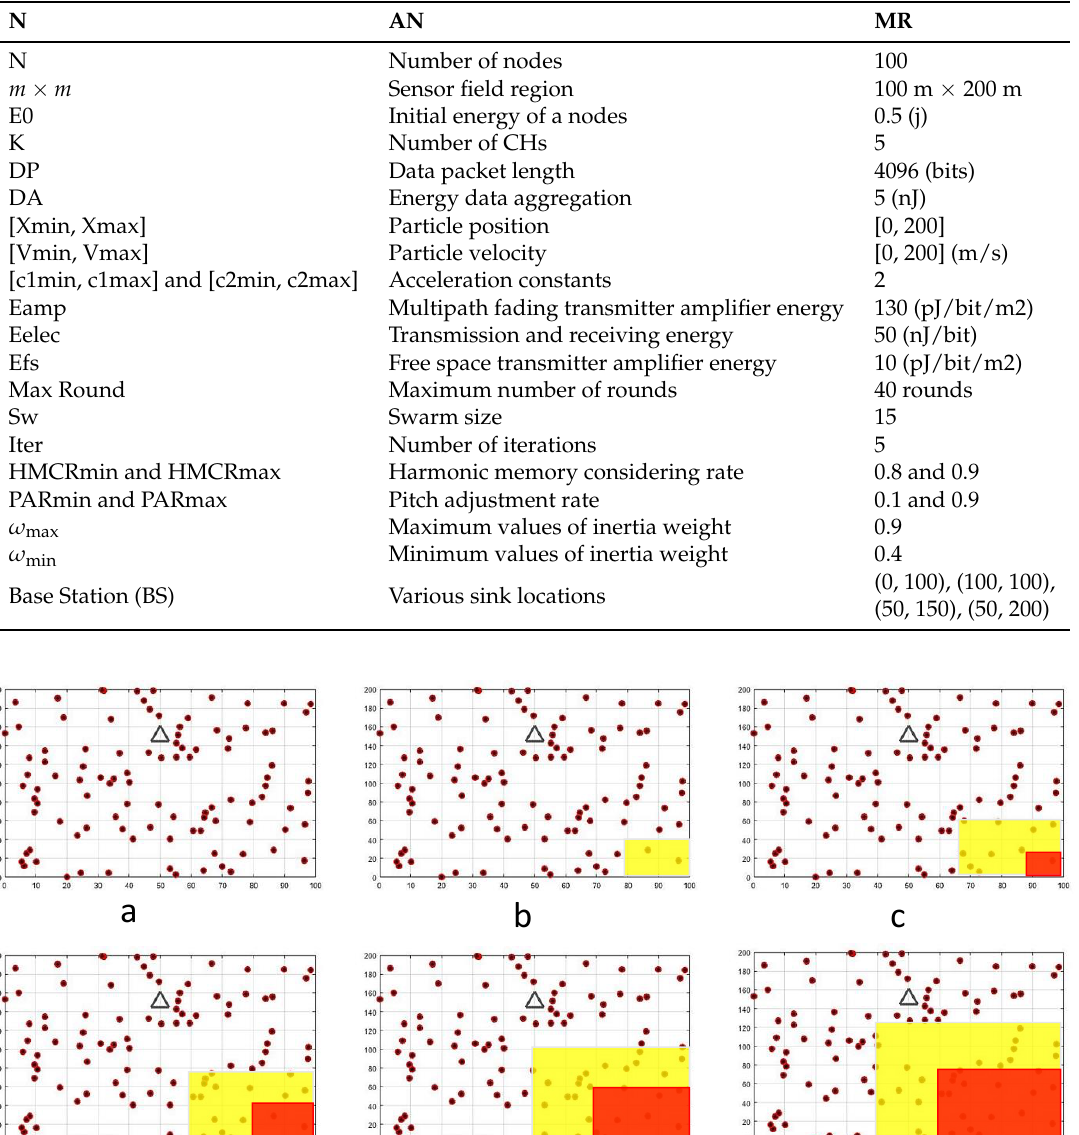
Table 2. Parameter settings for simulation.